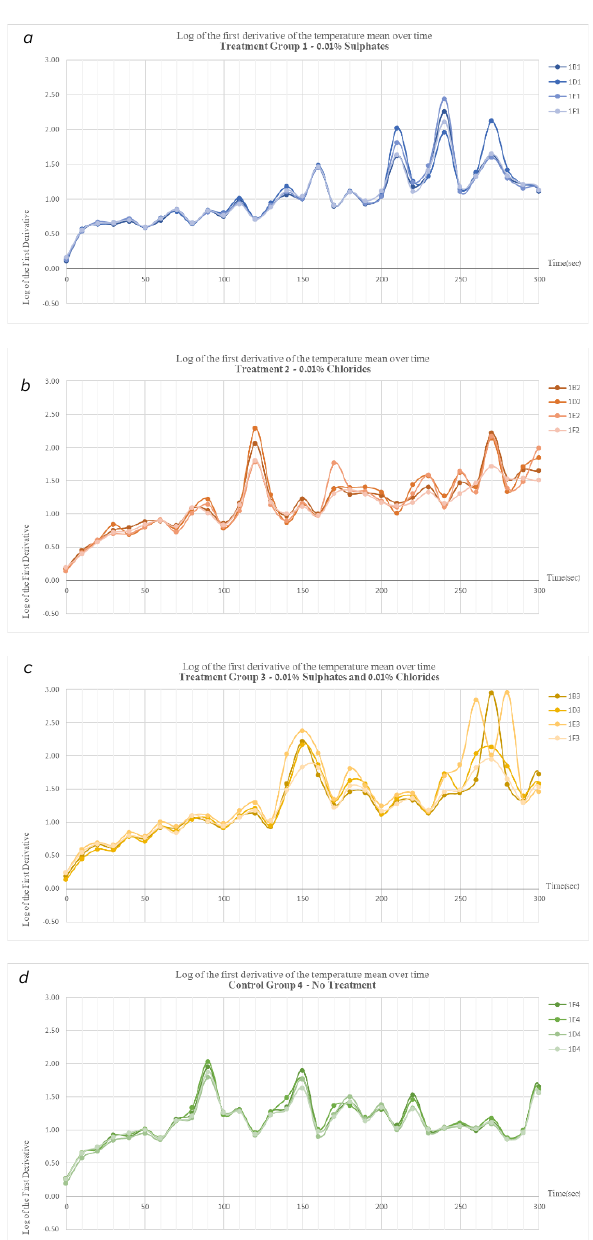
Figure 10. Log of the first derivative of the temperature mean over time. (a) treatment group 1, (b) treatment group 2, (c) treatment group 3 and (d) control group